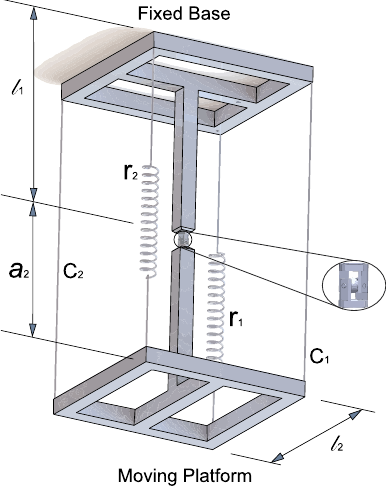
Figure 1. Class 2 tensegrity robot.